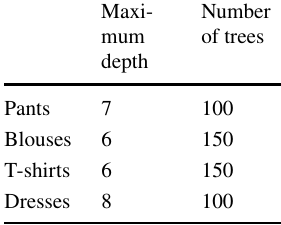
Table 3 Classification accuracies of the different classifiers